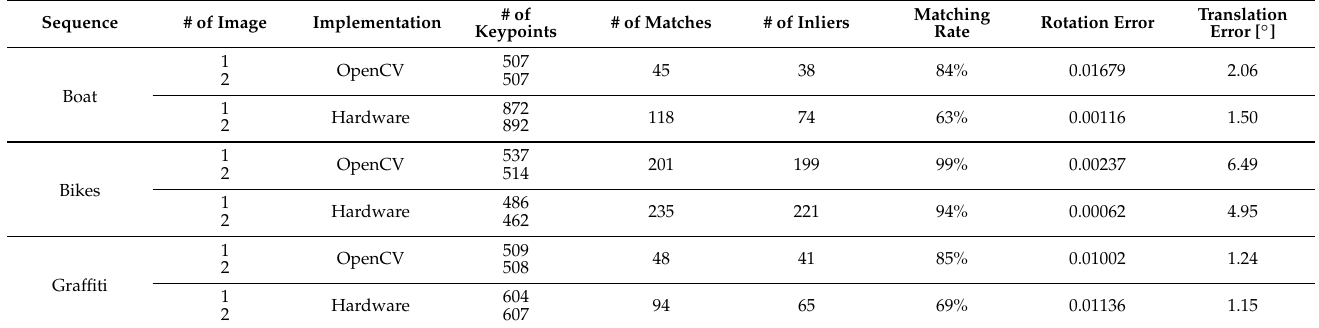
Table 4. Evaluation of the performance quality of our proposed implementation of the ORB algorithm.